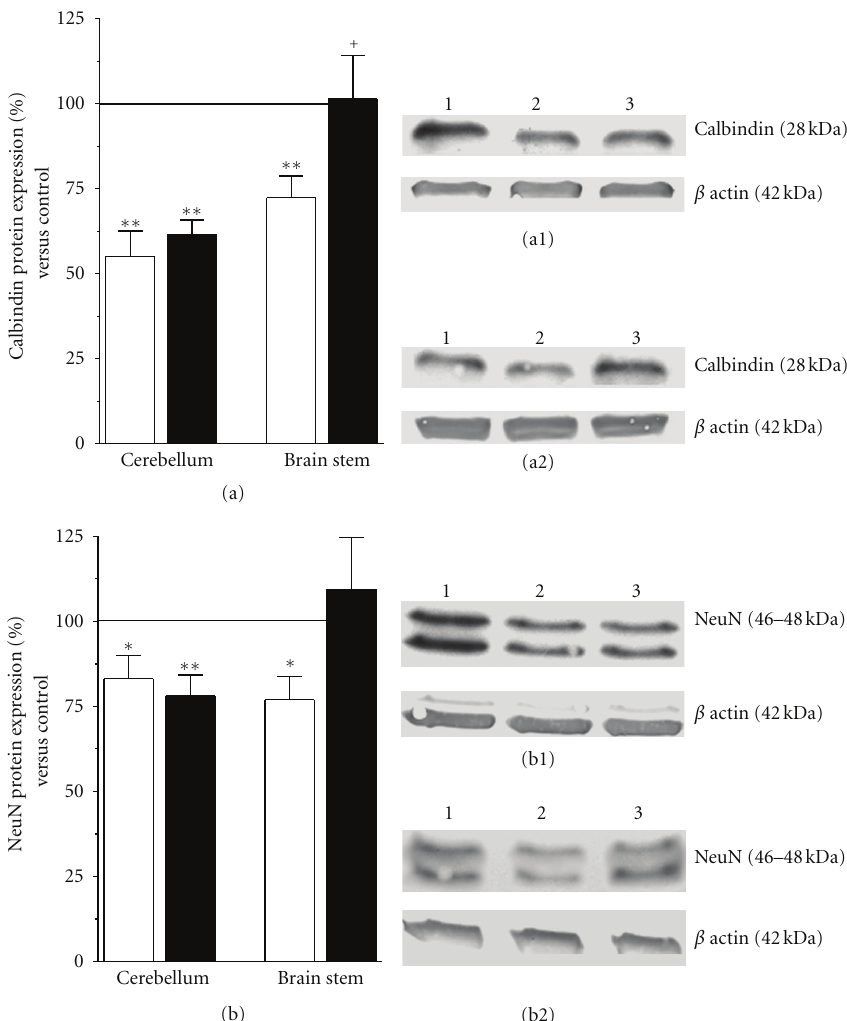
Figure 4: HuUCBMCs grafts partially prevent 3-AP-induced neuronal loss in the brain stem. (a) and (b) show the detection by western blot of calbindin (a) and neuronal nuclei (b, NeuN) in the cerebellum and brain stem of 3-AP-lesioned rats receiving vehicle (3-AP + vehicle rats, white bars) or HuUCBMCs grafts (3-AP + cells rats, black bars). (a1) and (a2) Show representative blots for calbindin, and (b1) and (b2) for NeuN in the cerebellum (a1, b1) and brain stem (a2, b2). Lane 1: na¨ıve rats (control); lane 2: 3-AP + vehicle; lane 3: 3-AP + cells. Results represent the mean ± SEM of 6 to 9 individual animals. ∗ P ≤ 0 . 05, ∗∗ P ≤ 0 . 01 versus na ¨ ıve rats, + P ≤ 0 . 05 versus 3-AP + vehicle